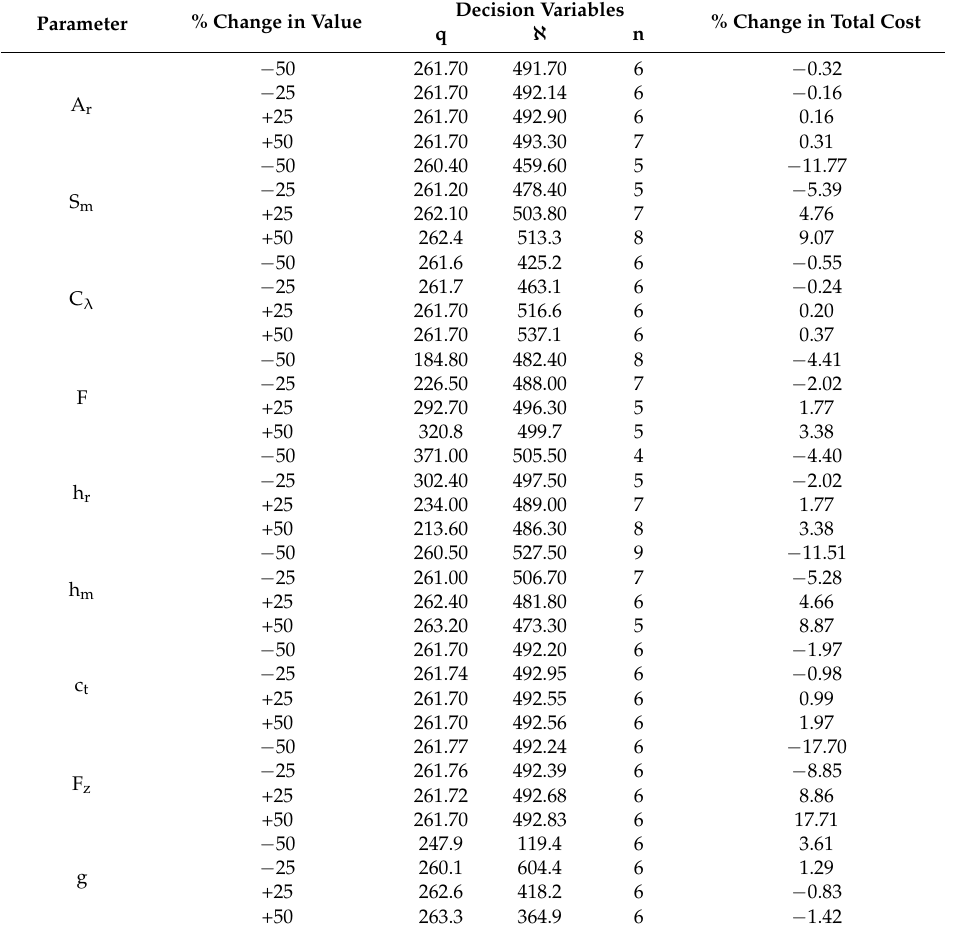
Table 2. Sensitivity analysis of input